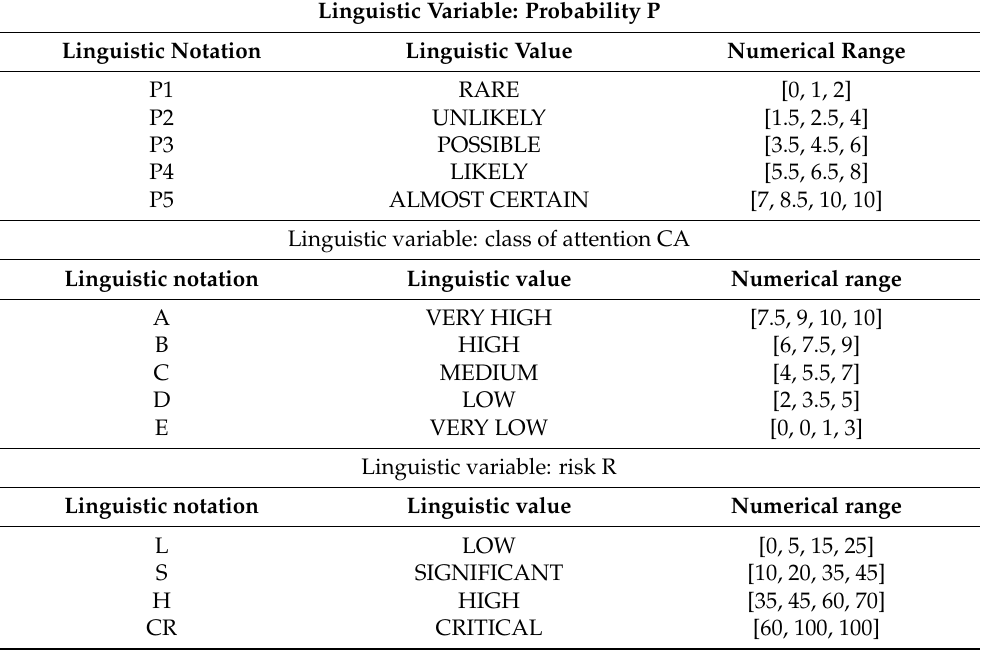
Figure 8. The risk categories’ fuzzy sets. Table 4. The numerical value of the linguistic P, CA, and R variables. Linguistic Variable: Probability P